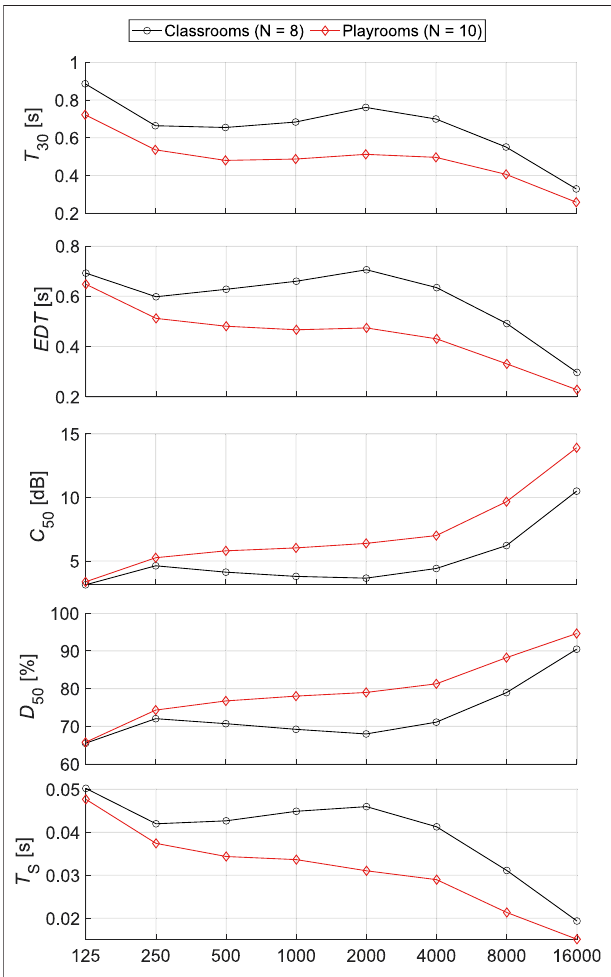
FIGURE 3 | Room acoustic parameters over 125 Hz – 16 kHz octave band frequencies for classrooms and